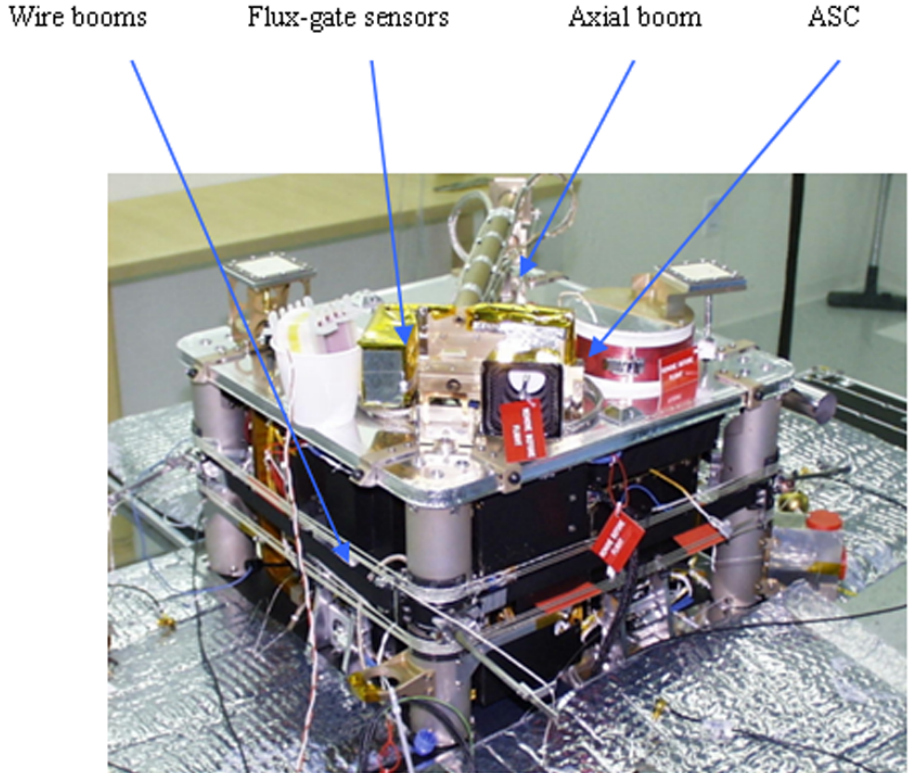
Fig. 3. The Astrid-2